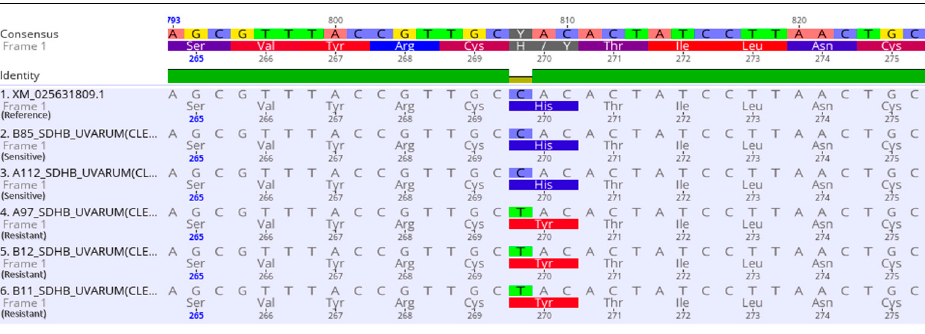
Figure 3. Multiple sequence alignment of nucleotides and amino acids of the sdhB gene in SDHI resistant isolates of Aspergillus uvarum possessing the H270Y mutation.